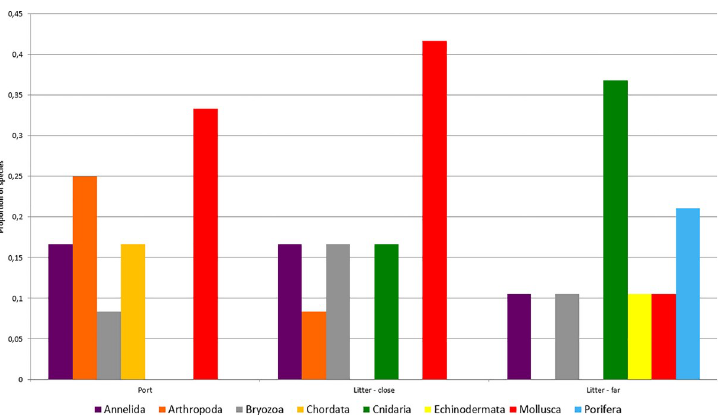
Fig 7. Proportion of species of different animal groups fouling Gijon old port piers and litter from beaches near (Litter-close) or apart (Litter-far) the port.